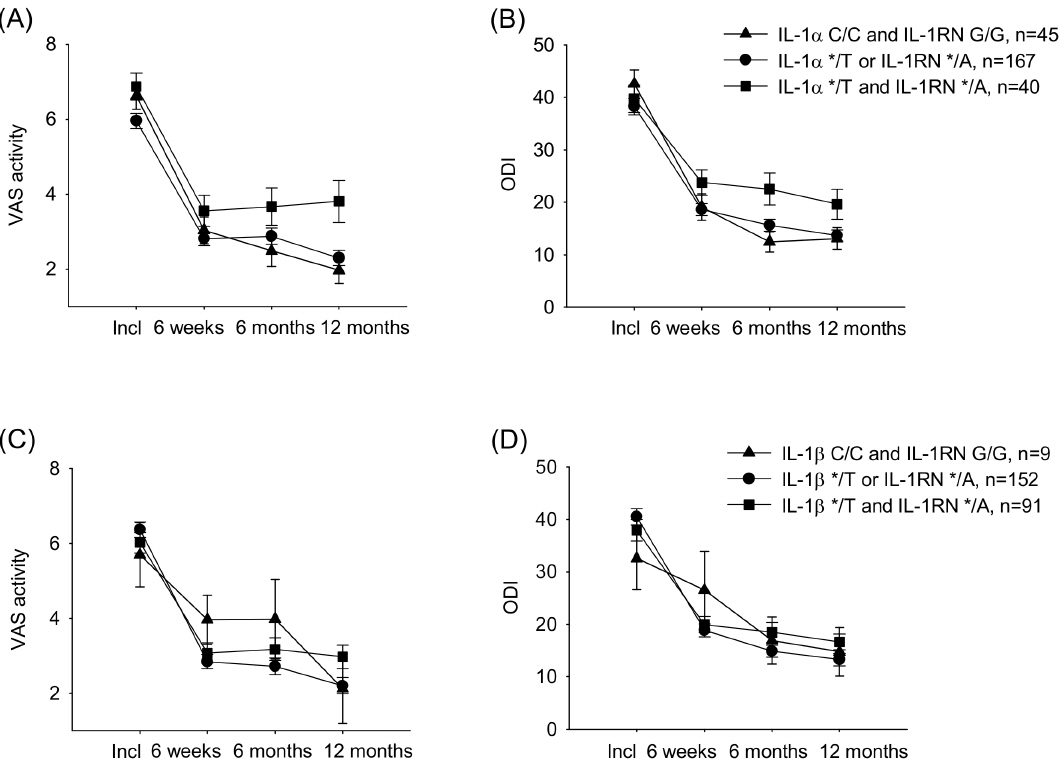
Figure 1. The time course of clinical outcome measures following disc herniation. A) and B) patients grouped by IL1A C/T and IL1RN G/A genotypes. VAS activity score ( p =0.049 rmANOVA; p =0.003 one-way ANOVA at 12 months), ODI score ( p =0.059 rmANOVA; p =0.050 one-way ANOVA at 12 months). C) and D) patients grouped by IL1B T/C and IL1RN G/A genotypes. VAS activity score ( p =0.175 rm ANOVA; p =0.105 one-way ANOVA at 12 months), ODI score ( p =0.055 rmANOVA; p =0.214 one-way ANOVA at 12 months). Data are shown as means 6